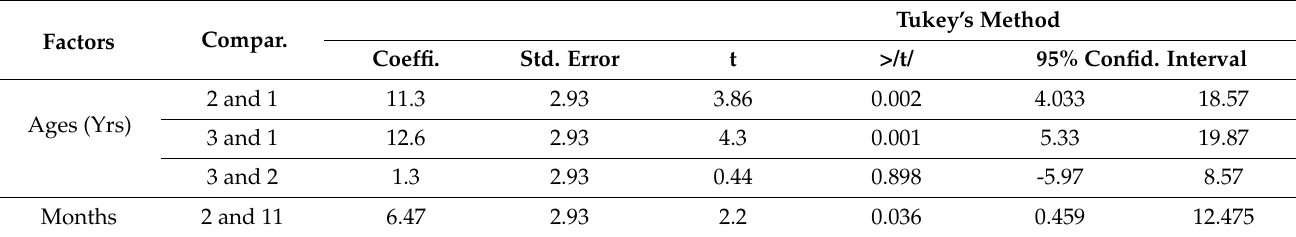
Table 4. Pairwise comparisons of the mean of Young’s moduli for the Kombolcha bamboo.